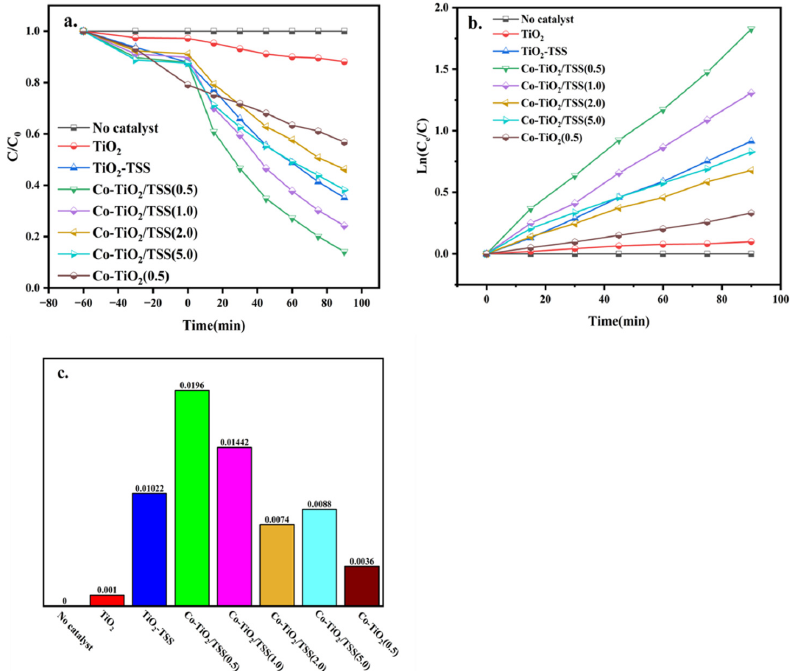
Figure 5. ( a ) TCH removal kinetics, ( b ) plot of ln (C e /C) versus irradiation time, ( c ) pseudo-first-order rate constants, k (min − 1 ), for photocatalysis with pure TiO 2 , TiO 2 -TSS, Co-TiO 2 , and Co-TiO 2 /TSS(X).